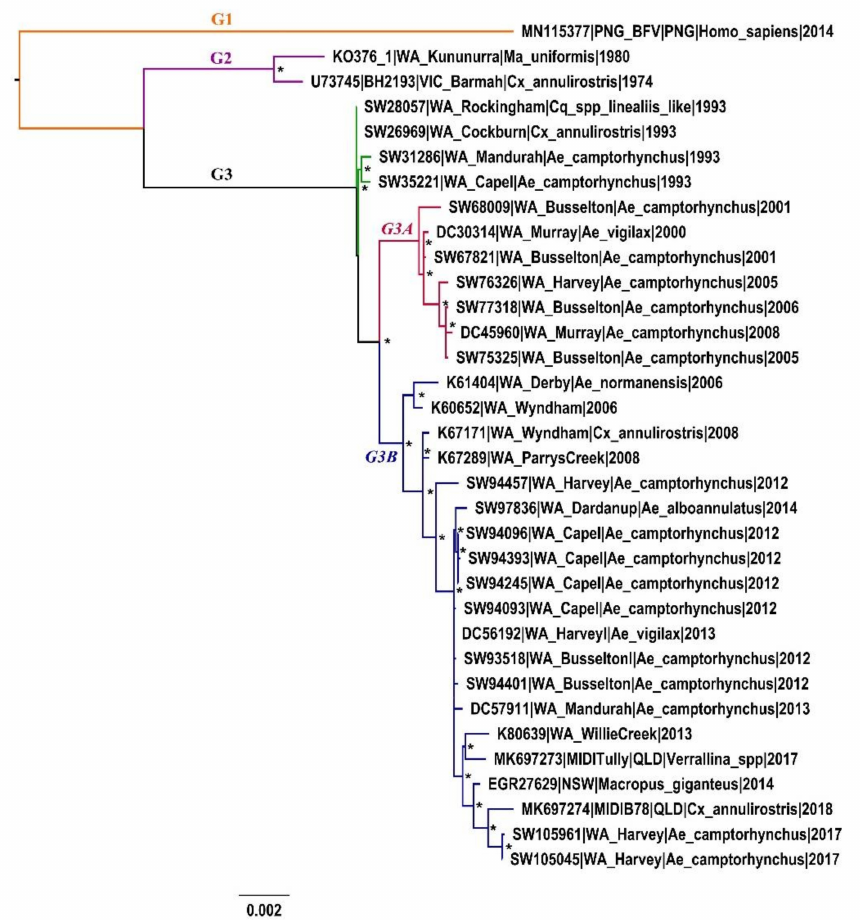
Figure 2. Midpoint-rooted maximum likelihood phylogeny of the 34-taxon complete coding region Barmah Forest virus dataset. The three major genotypes (G1–3) and the minor sublineages of G3 have been labelled. Asterisks indicate nodes with bootstrap values over